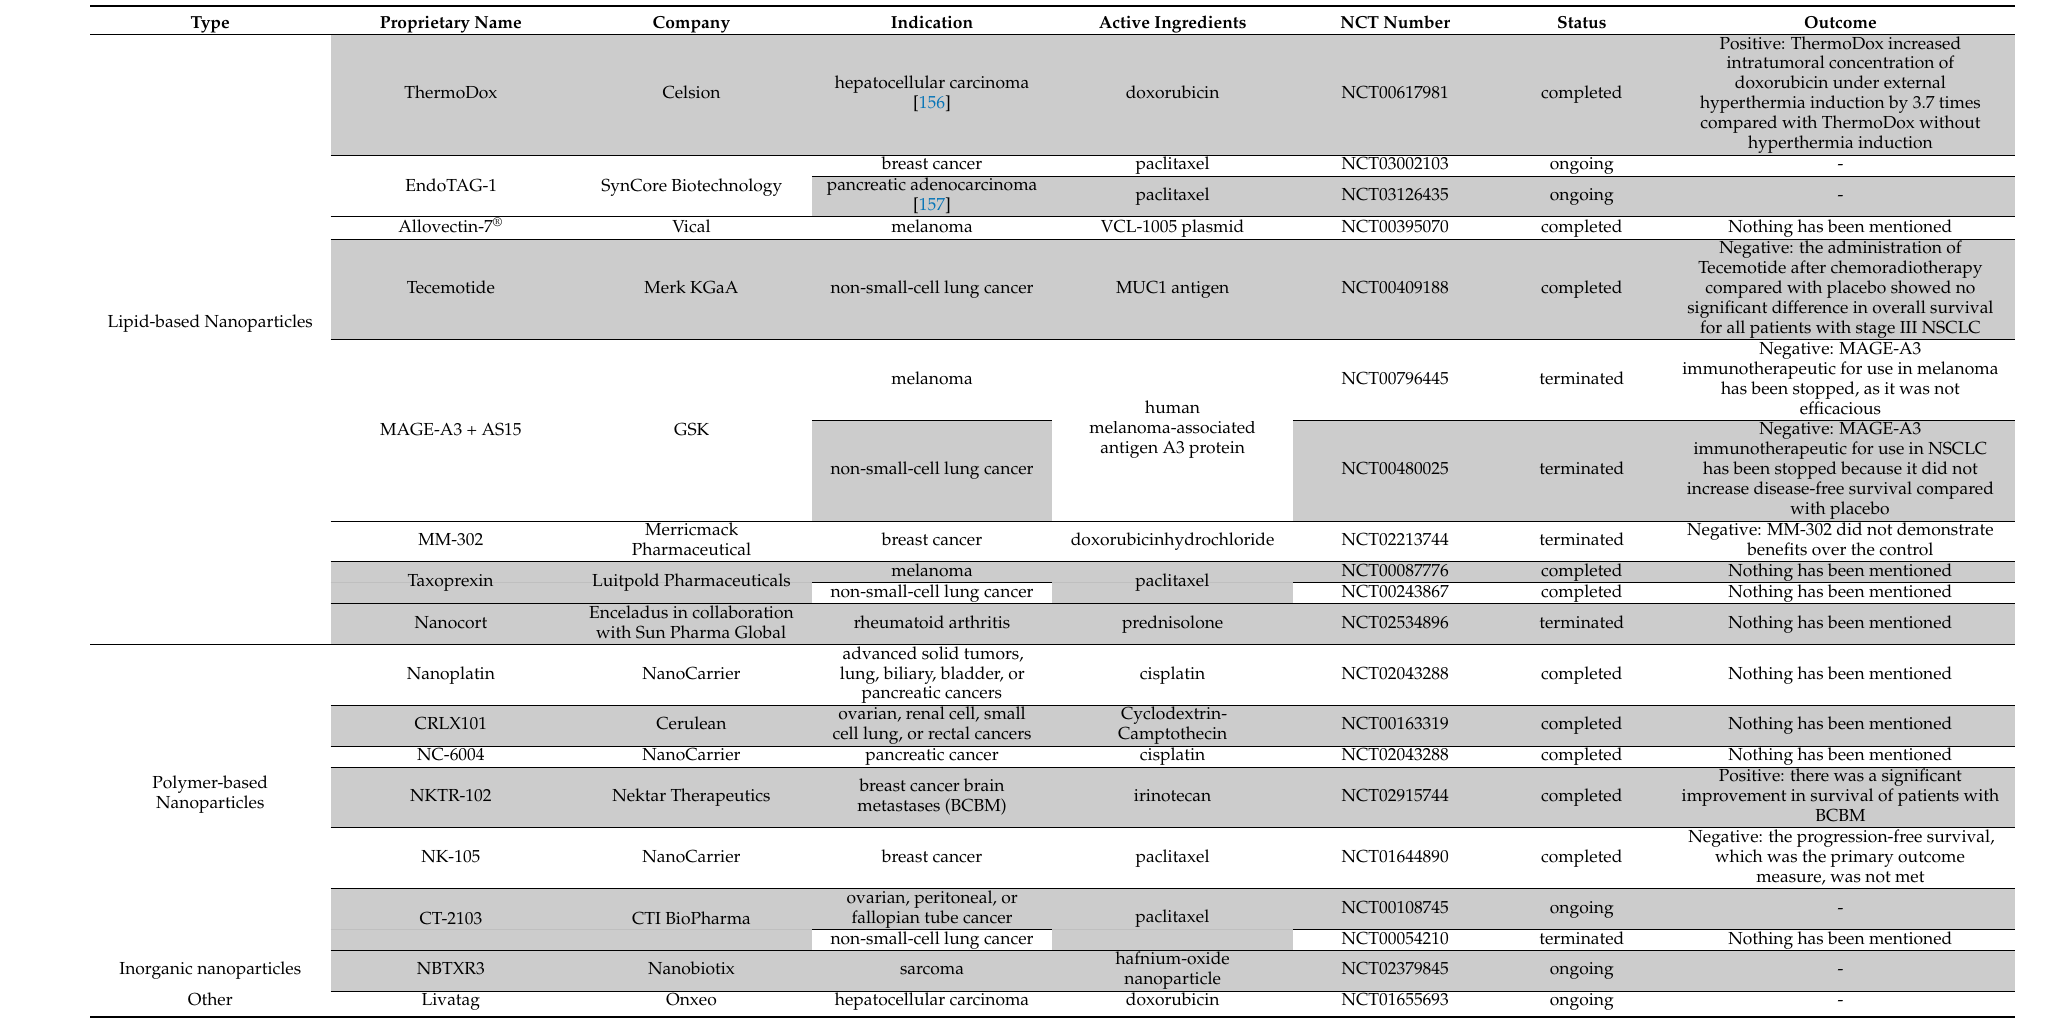
Table 2. Selected nanomedicines that are in phase III clinical